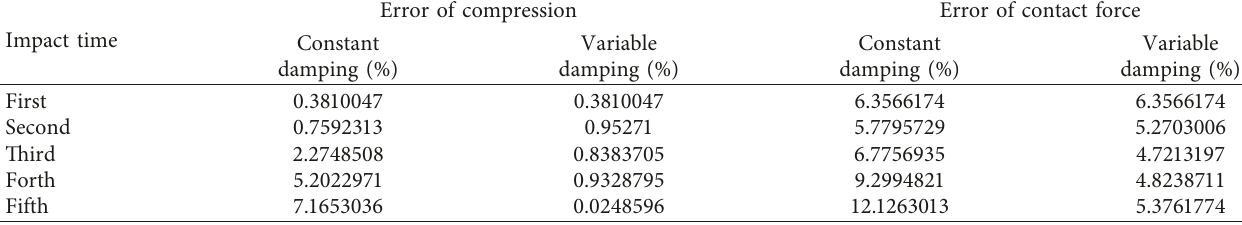
Table 2: Error between the simulation and theoretical value.